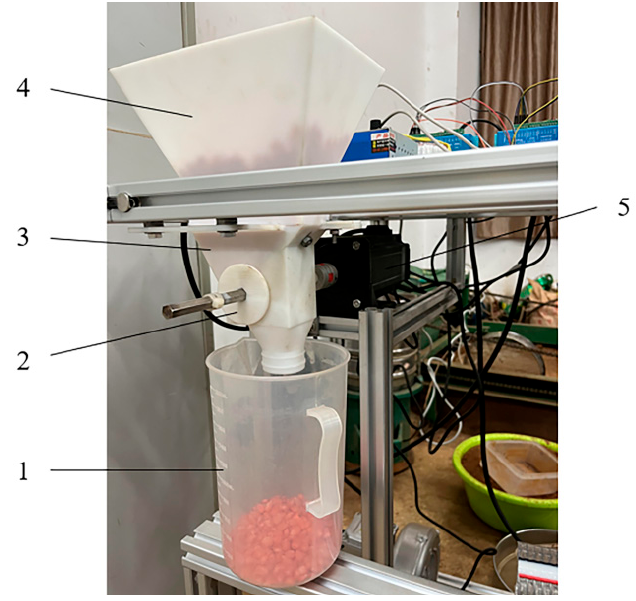
Figure 8. Bench test device. 1. Seed collection box; 2. seed feeding wheel; 3. seed filling box; 4. seed inlet; 5. stepper motor.